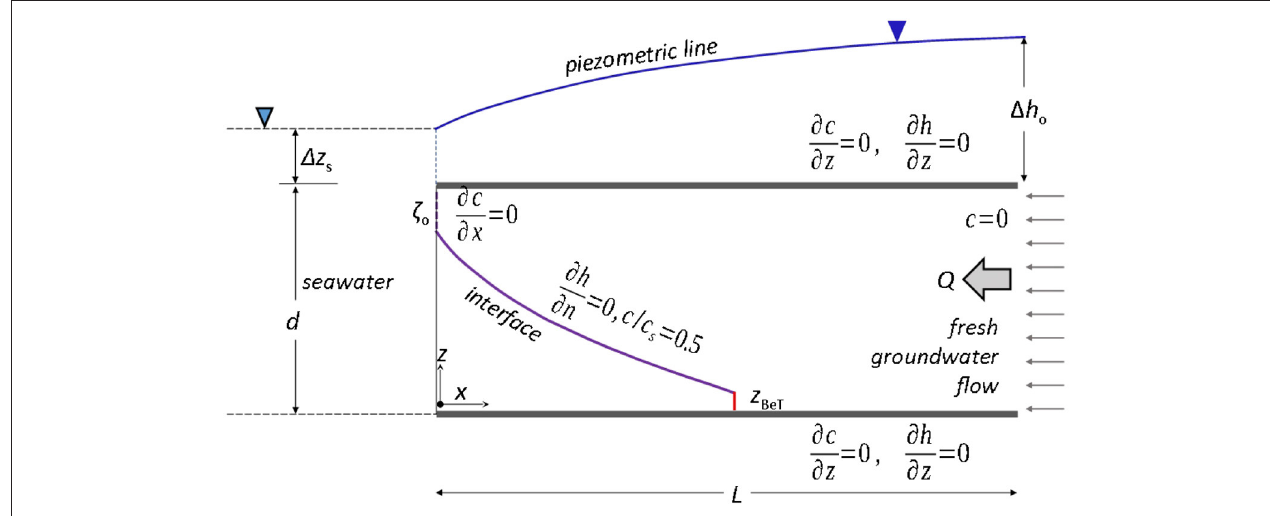
FIGURE 1 | Schematized 2-D confined coastal aquifer, with nominal interface and boundary conditions. Reprinted from Mazi and Koussis (2021).